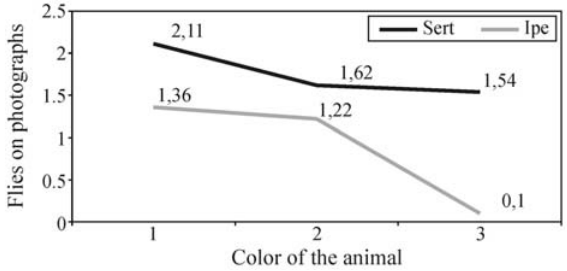
Table 1 - Descriptive statistics of number of flies counted on animals (FC), number of flies in photographs (FF), and of infestation score (FS). Trait